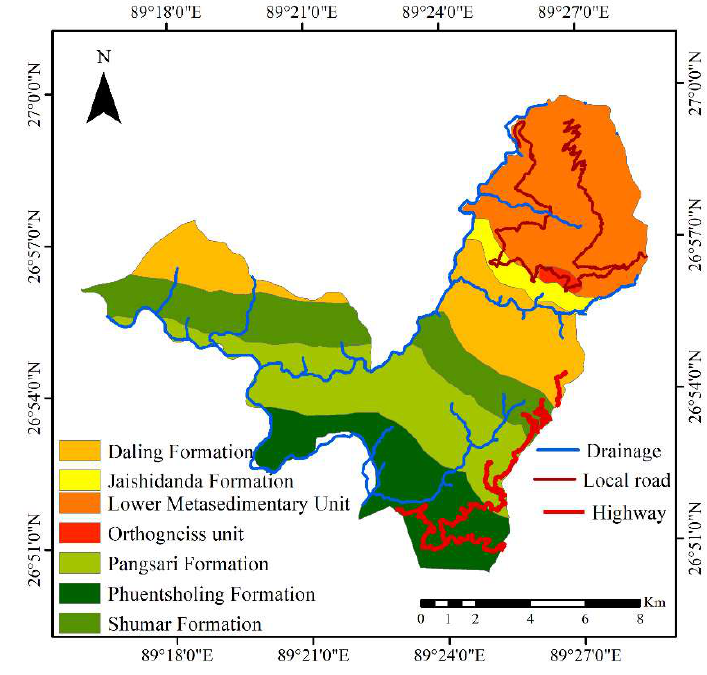
Figure 3. Geological map of the study area.